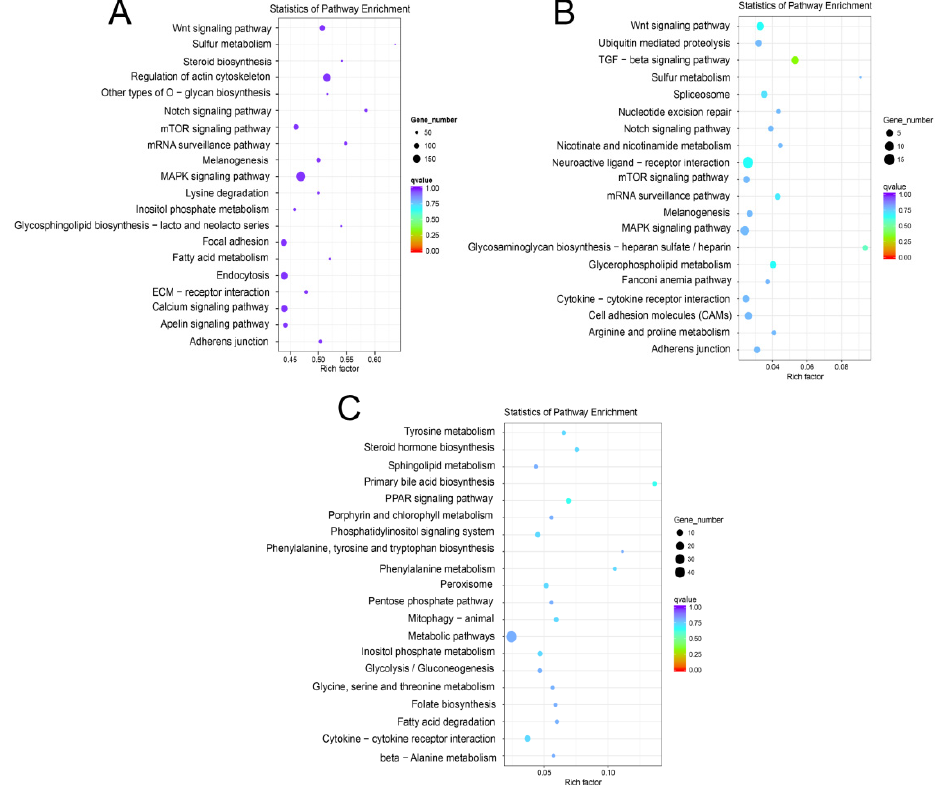
Figure 5. KEGG enrichment results. ( A ): Differentially expressed miRNA target genes. ( B ): The target genes of the highly expressed miRNAs in the ovaries. ( C ): The target genes of the highly expressed miRNAs in the testes.